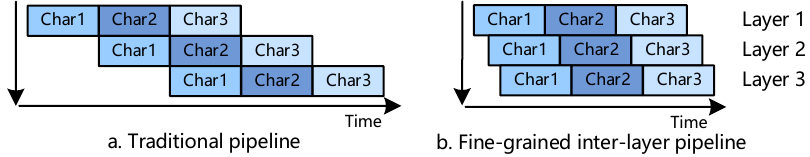
Figure 9. The proposed fine-grained interlayer pipeline for layer fusion: ( a ) in a traditional interlayer pipeline, subsequent computations require all of the previous layer’s results. ( b ) The proposed fine-grained interlayer pipeline requires only a small number of results for starting